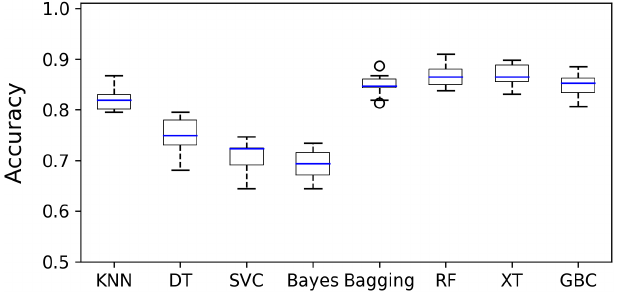
FIG. 6. Boxplots showing accuracy scores from a tenfold cross- validation analysis of several algorithms for cavity identification. The blue line denotes the median, the box spans the interquartile range (IQR), and the upper (lower) whiskers indicate values 1 . 5 × IQR above (below) the upper (lower) box boundary, with data beyond the whiskers represented as open markers. Ensemble models (four rightmost boxplots) exhibit the best performance.